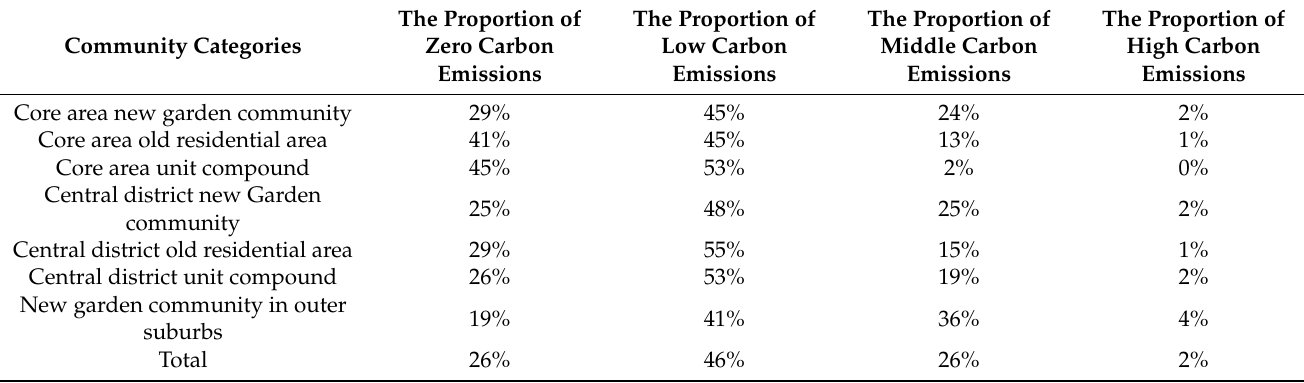
Table 5. Grading distribution of residents’ travel daily carbon emissions in different types of communities.